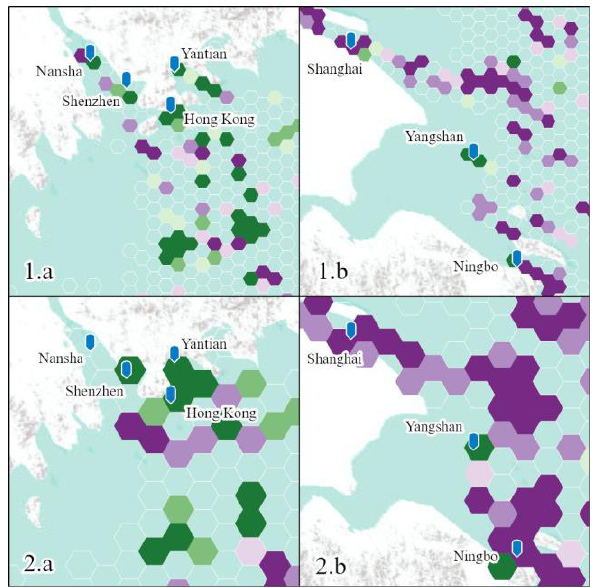
Figure 20 Trend analysis on mean TEU over all bin locations, for Hong Kong – Shenzhen (a) and Shanghai (b) areas. The height of hexagonal spatial grid change from 10 km (1) to 20 km (2). (Basemap sources: Esri, USGS,